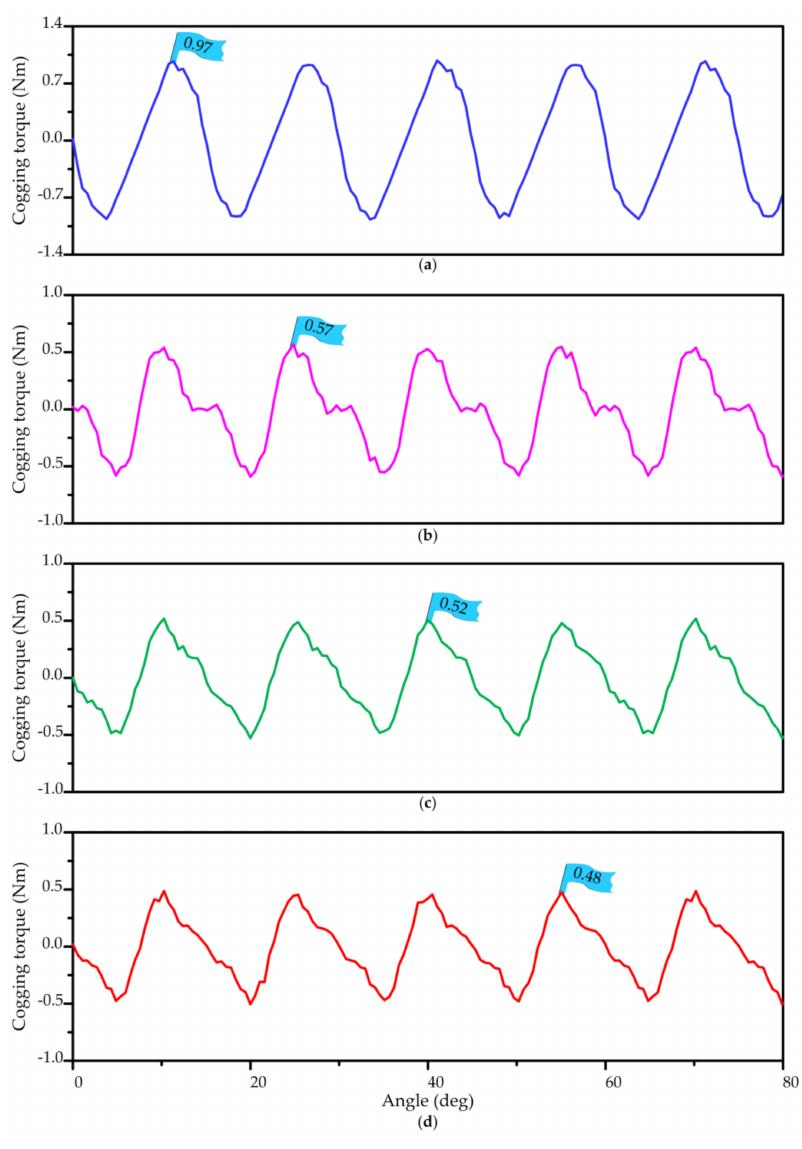
Figure 12. Cogging torque: ( a ) I shape rotor core; ( b ) Wider “I” shape rotor core; ( c ) “T” shape rotor core; ( d ) Five-stair-step shape rotor core.